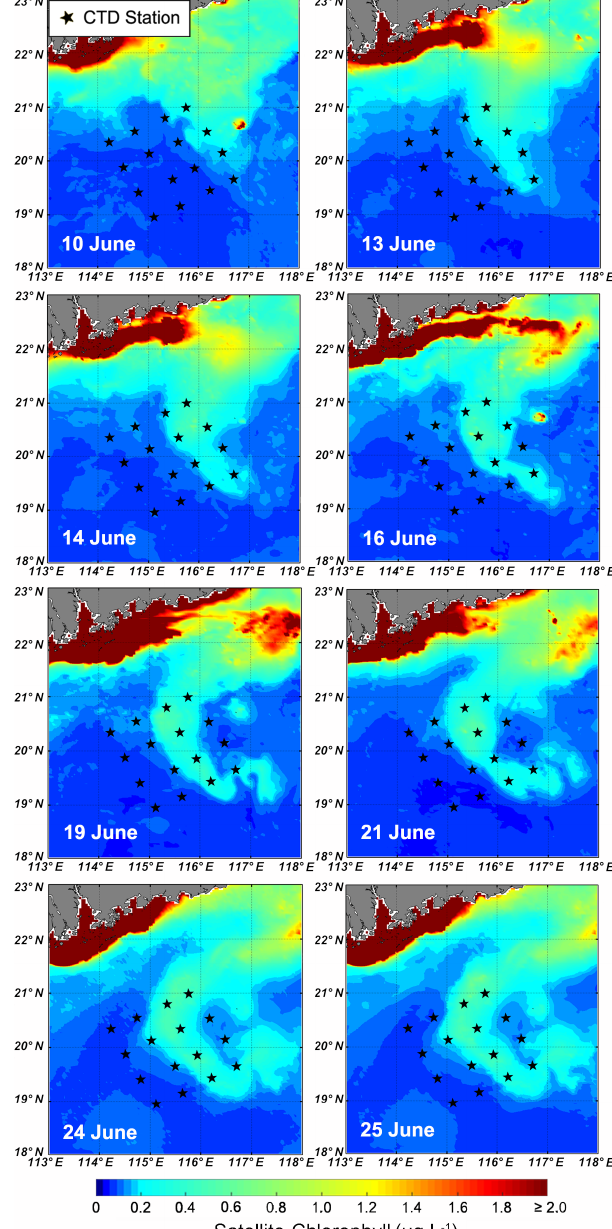
Figure 10. Daily satellite chlorophyll images on selected days in June 2015. Stars represent CTD locations. We roughly set satellite chlorophyll to ≥ 0 . 2µgL − 1 in this figure as the criterion for shelf water. This figure was made based on the M_Map mapping package for MATLAB (Pawlowicz,